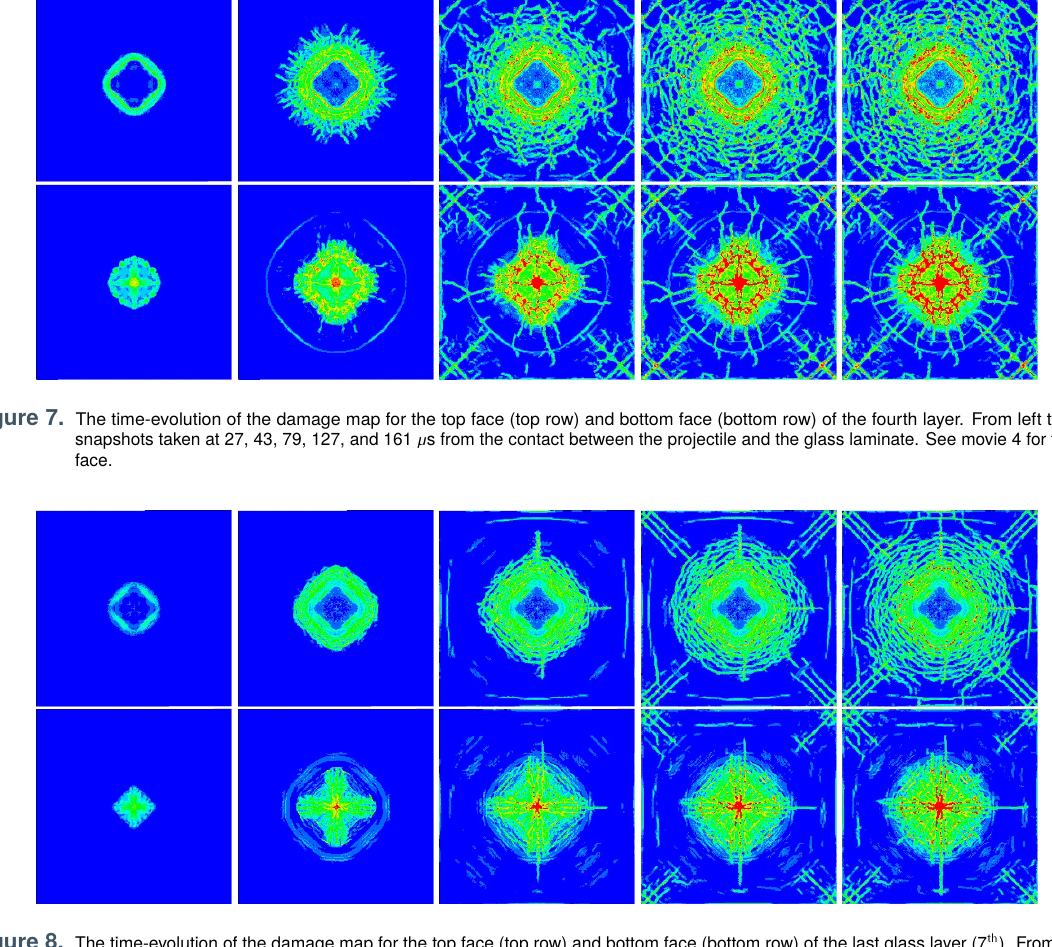
Figure 8. The time-evolution of the damage map for the top face (top row) and bottom face (bottom row) of the last glass layer (7 th ). From left to right, snapshots taken at 36, 50, 79, 110, and 161 µ s from the contact between the projectile and the glass laminate. See movie 5 for the top